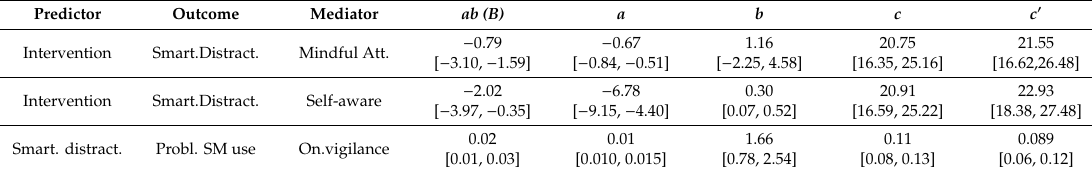
Table 5. Mediation e ff ects of mindful attention and emotional self-awareness on intervention e ff ects and smartphone distraction and of online vigilance on smartphone distraction and social media addiction ( n =